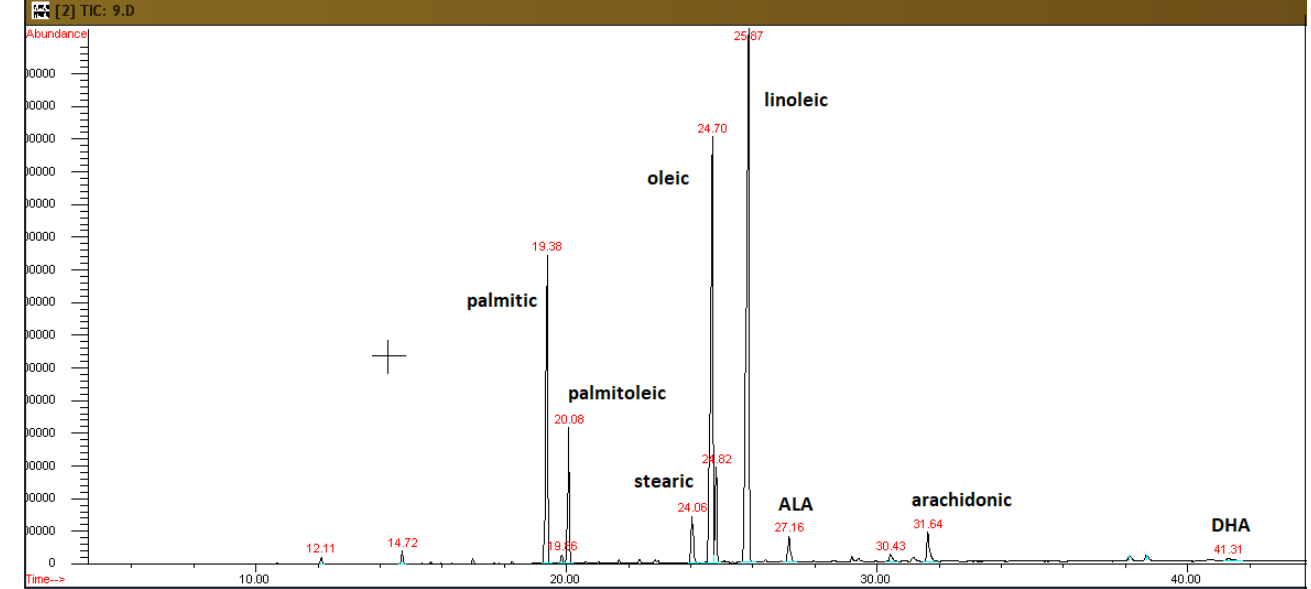
Figure 1. A typical chromatogram of fatty acids methyl esters from a VAT sample of a diabetic rat receiving the pistachio diet.